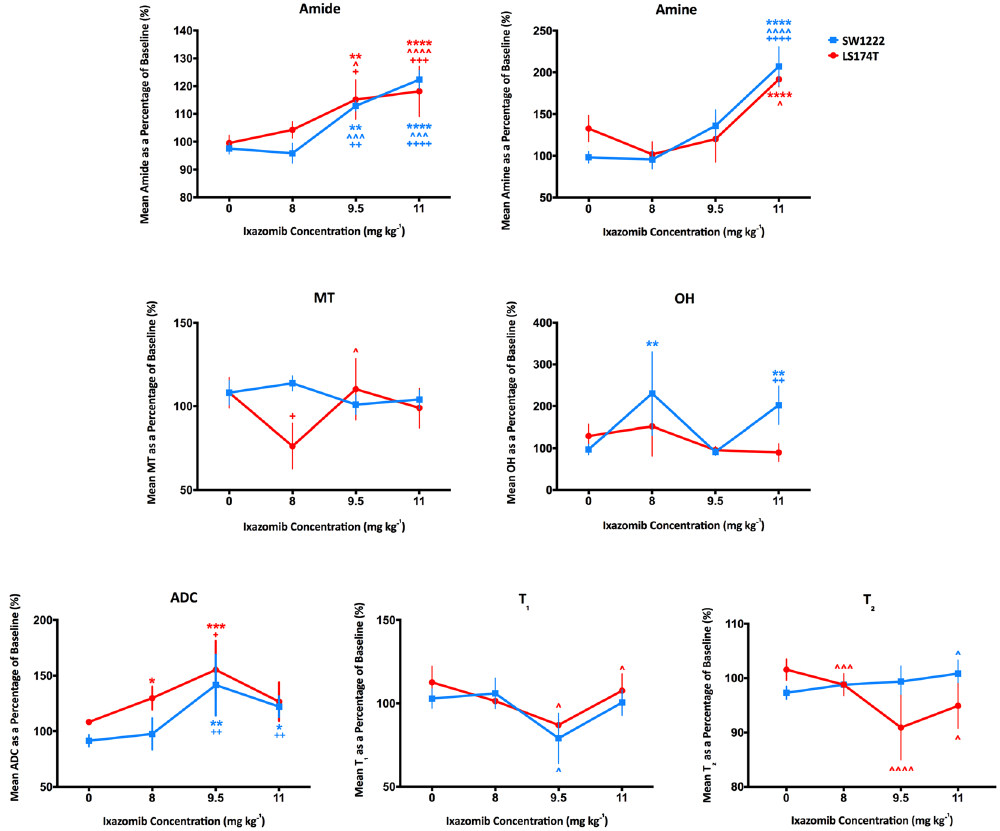
Figure 4. Summary of changes in quantitative, non-invasive MRI parameters, as a function of Ixazomib dose (8, 9.5 and 11 mg kg − 1 ), at 72 hours post-dosing. Only CEST measurements associated with amines and amide groups show a correspondence with Ixazomib dose. Significant increases, in a dose-dependent manner, were observed in amine and amide peak areas from CEST MRI measurements. Tumor apparent diffusion coefficient (ADC) also increased significantly for the two highest doses, and T 2 decreased significantly in LS174T tumors only (the top and bottom set of asterisks or crosses represents LS174T and LS174T, respectively, where two mean values overlap). Data points are mean ± standard error; * P < 0.05, ** P < 0.01, *** P < 0.001, **** P < 0.0001 (two-way ANOVA); * compared to baseline, ^ compared to measurement at 24 hours post- Ixazomib dose, + compared to